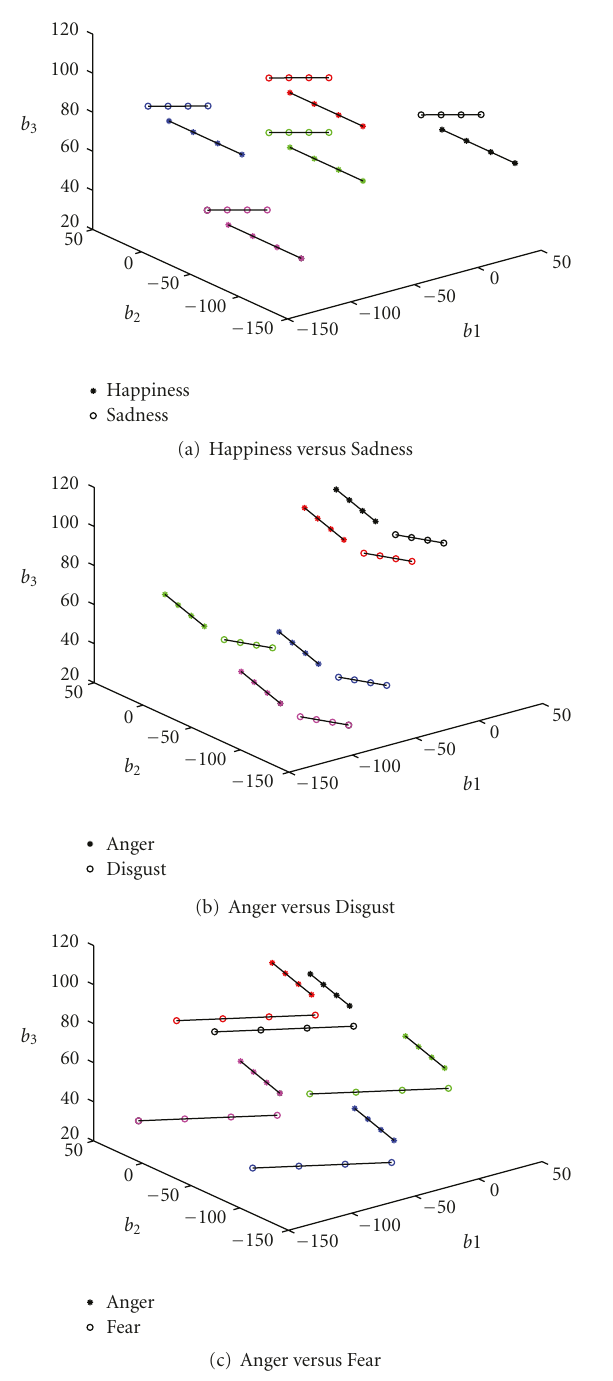
Figure 5: Visualization of the synthetic faces separability using first three elements of the SSV and five di ff erent subjects.